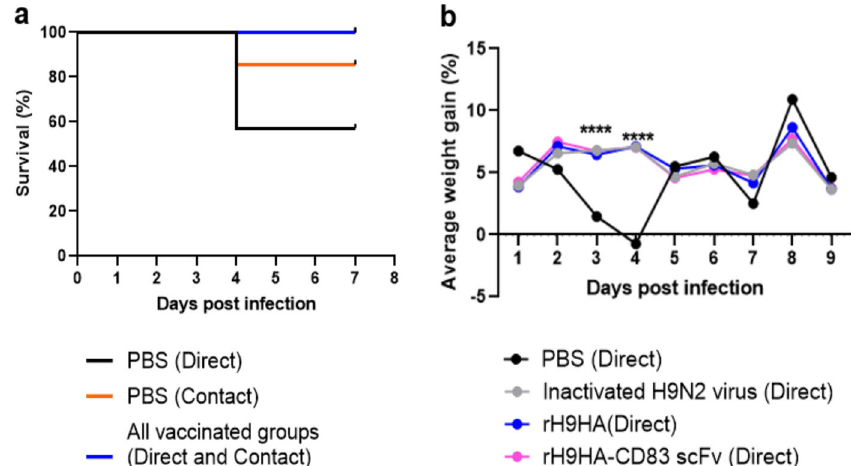
Fig. 8 Survival and average weight gain of chickens after virus challenge. a Percentage survival between vaccinated and PBS treated control chickens challenged with H9N2 virus. Directly infected and contact birds were monitored for clinical disease signs throughout the study duration. Birds that reached the humane endpoints were culled due to ethical reasons. Survival curves between directly infected PBS control group (black line) and directly infected or contact vaccinated groups (blue line) signi fi cantly different P- value ≤ 0.05 (log-rank (Mantel − Cox) test). b Percentage average weight gain per day between vaccinated and PBS treated control chickens challenged with H9N2 virus. Chickens were weighted daily during the study duration. Data are analysed by one-way ANOVA followed by Tukey ’ s multiple comparison test. Statistical signi fi cance between the vaccinated and PBS treated control groups is shown with asterisks **** p <